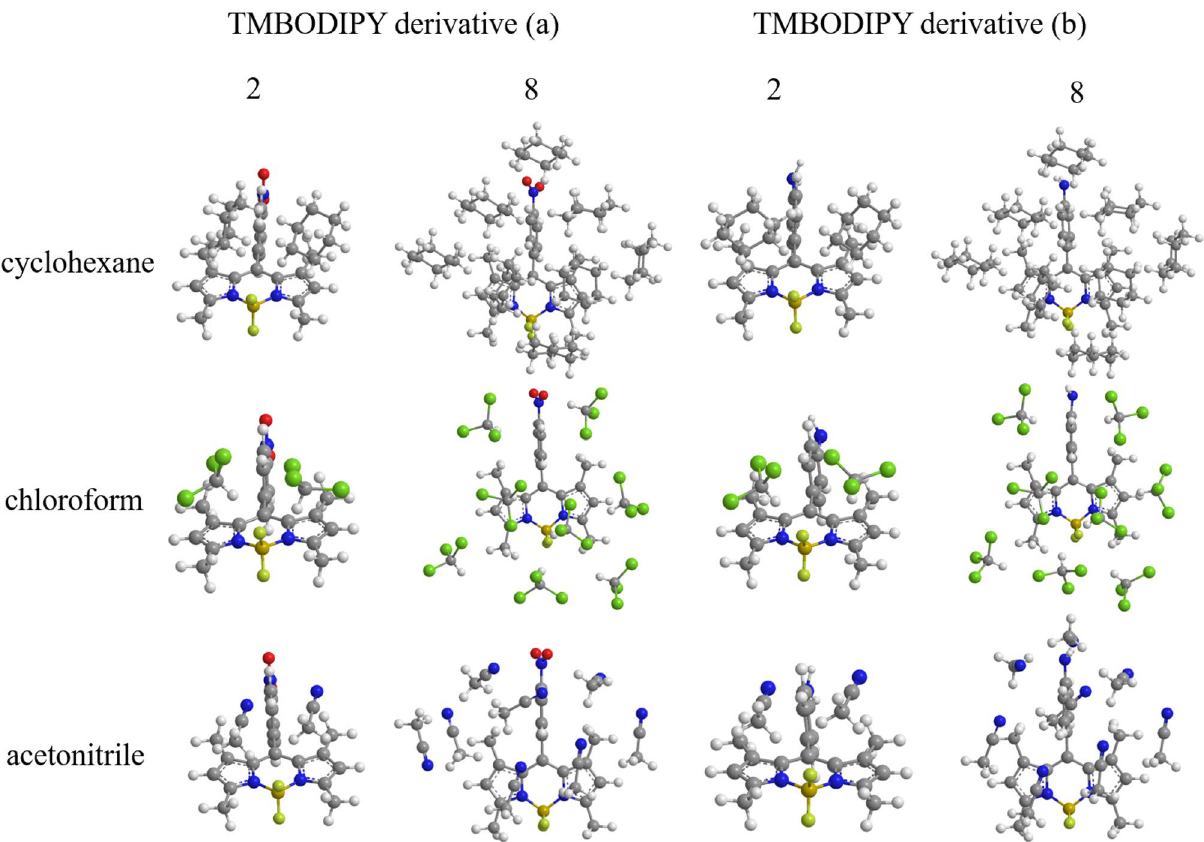
Figure 2. Optimized structures of TMBODIPY derivatives ( a ) and ( b ) monomers adsorbing two and eight solvent molecules to the single side in the monolayers for three types of solvent molecules: cyclohexane, chloroform and acetonitrile. For each adsorption, the corresponding solvent effects are incorporated by